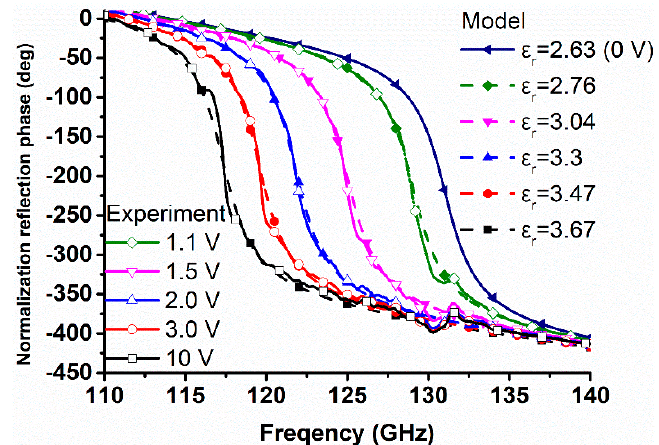
Figure 9. Simulated (dashed line) and measured (solid line) reflection phase of the liquid crystal based phase shifter at different relative permittivity and bias.